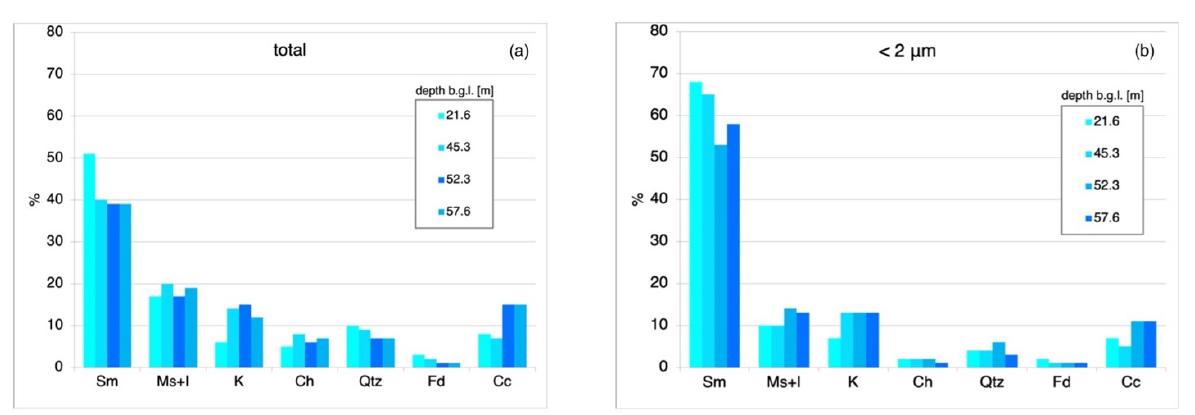
Figure 13. X-ray diffractometry on clayey Faeto Flysch samples from Bovino: ( a ) total sample; ( b ) clay fraction.